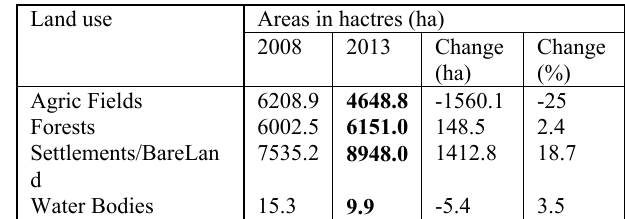
Table 3. Land cover change 2008-2013